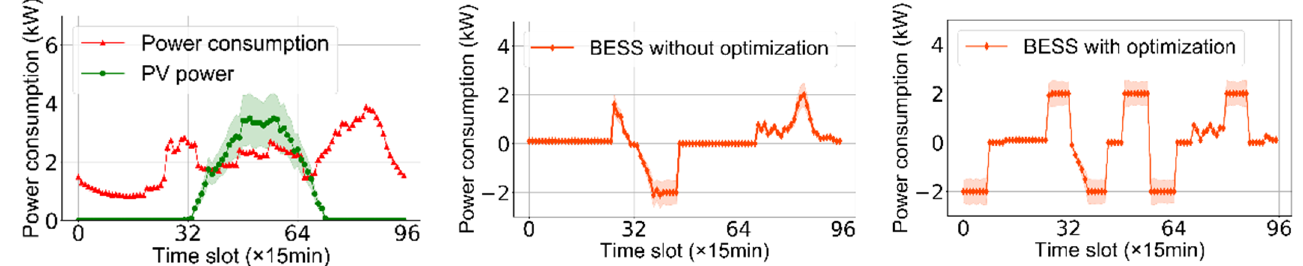
Figure 9. Power consumption, PV power, and BESS power of consumer II .